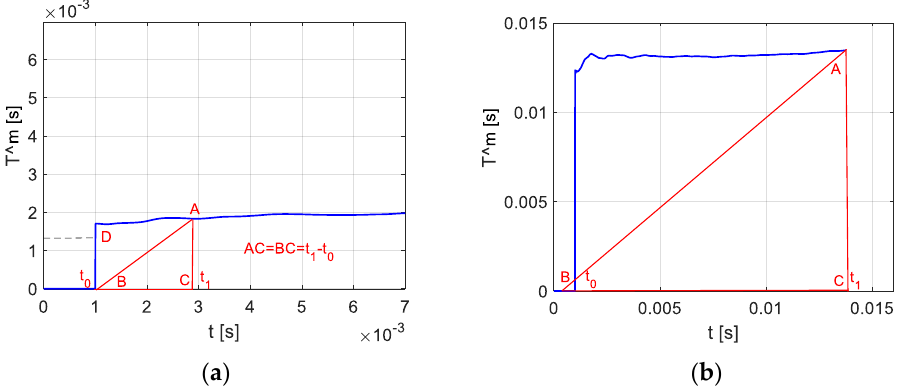
Figure 11. Calculation of 𝑇 ̂ 𝑒 : ( a ) with the bisector method; ( b ) with the extension of the bisector method.